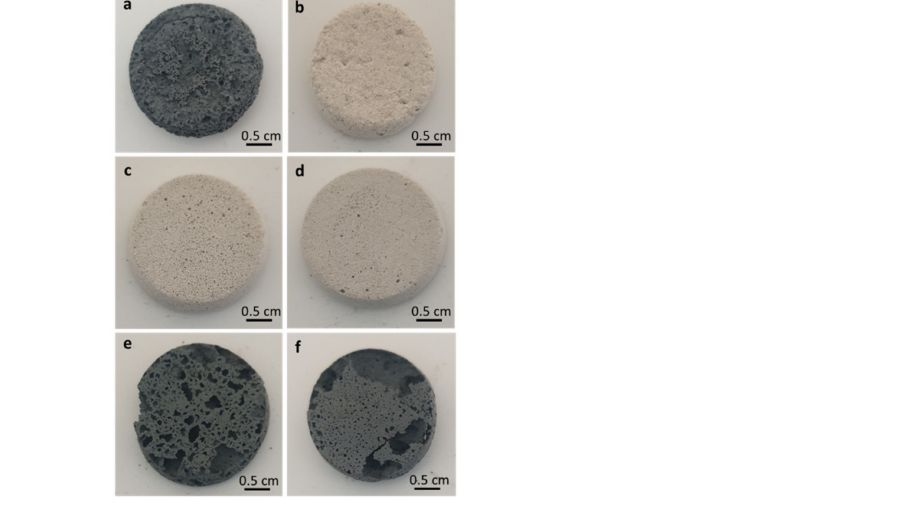
Figure 1. Images of samples synthetized with silica fume ( a , e , f ) and with bottom ash ( b – d